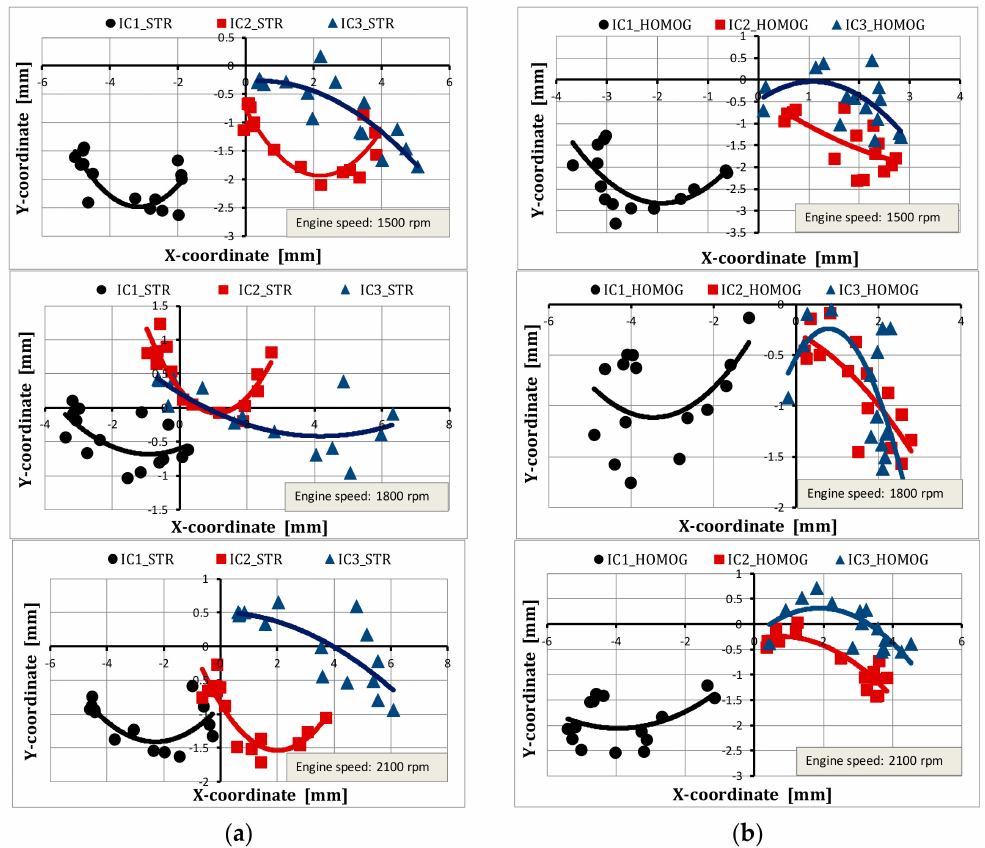
Figure 12. Flame center position relative to spark center at variable engine speeds and induction cases: early flames positioned on the ( a ) end of the curves and late flames on the right end, with ( b ) time flame positions